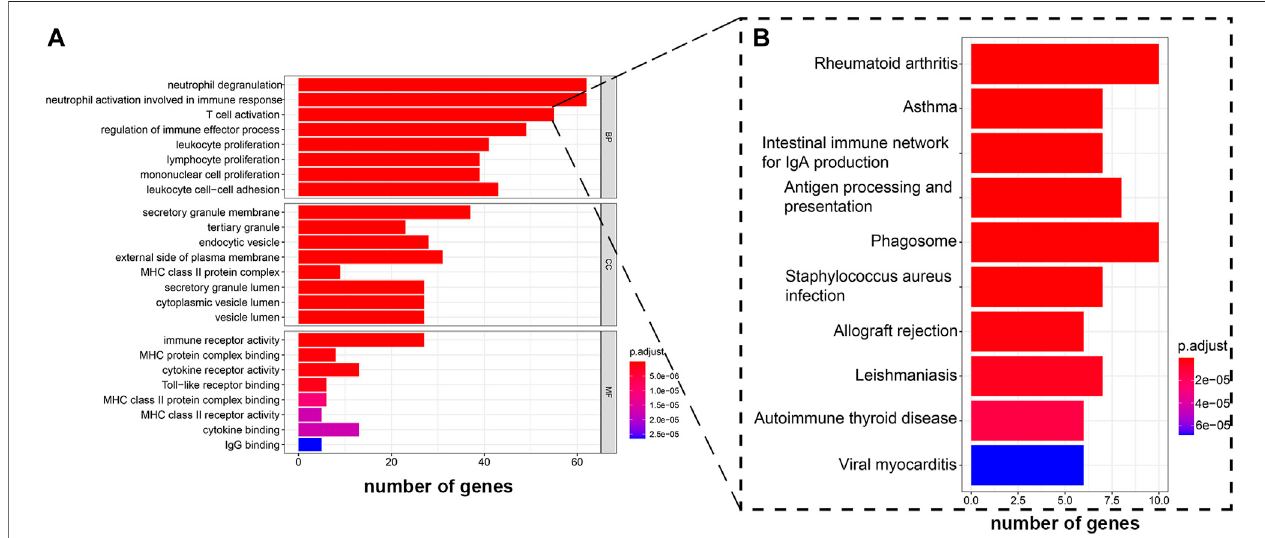
FIGURE 6 | GO enrichment analysis and KEGG pathway analysis were performed on hub genes. (A) GO enrichment analysis shows the hub genes participate in T cell activation. (B) KEGG pathway analysis displays the genes that activated T cells participated in antigen processing and presentation.